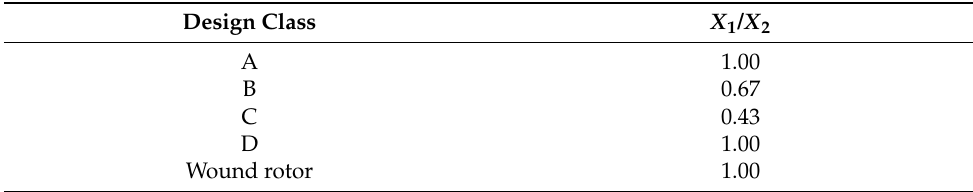
Figure 4. Measured stator current and rotor harmonic frequency: ( a ). measured phase-A currents; ( b ). extracted rotor slot harmonics frequency (734 Hz) for 5.5 kW motor, with slot number Z = 28 and pole pair number p = 2; the corresponding speed is 1465.71 r/min after recorded data analysis.